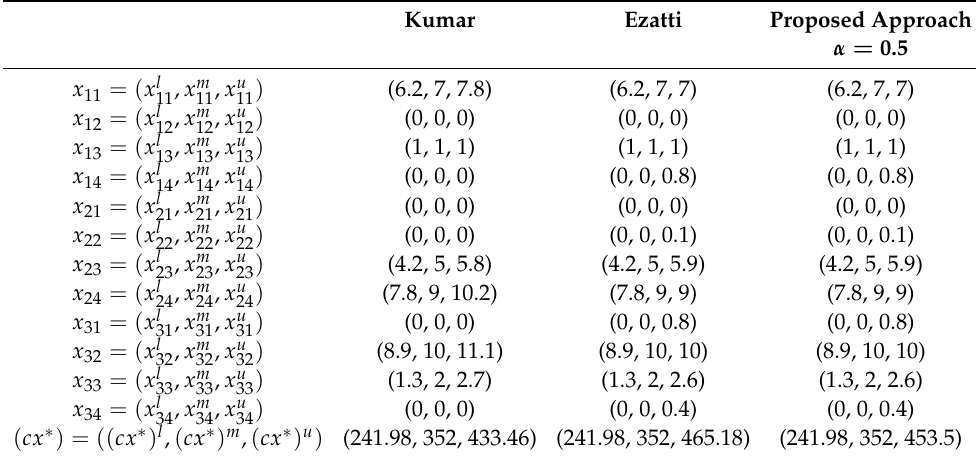
Table 2. Comparison of proposed method with other existing methods.